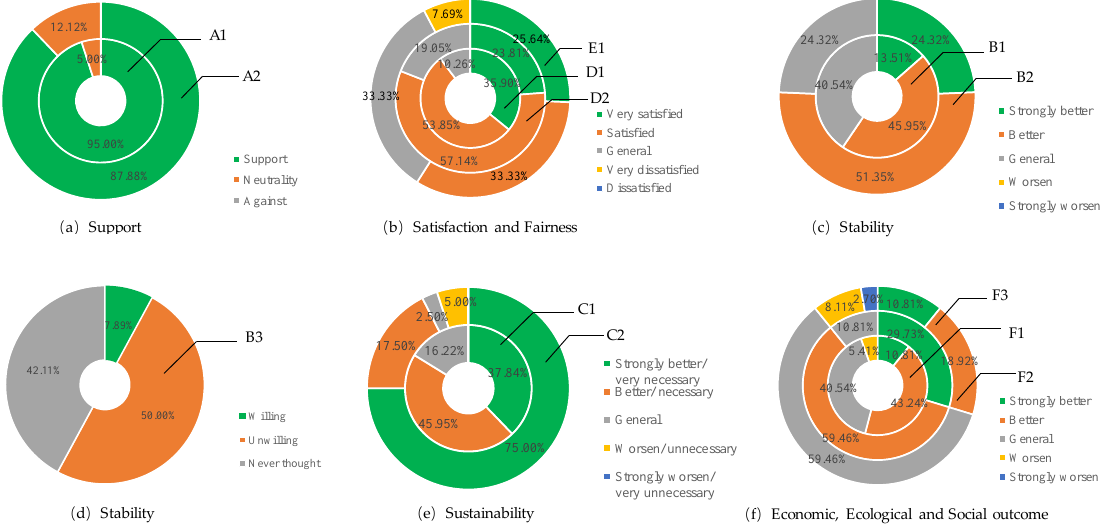
Figure 5. Frequency distribution of rangers’ evaluations on each indicator. ( a ) indicate that the rangers’ perception on NFRPP support. ( b ) indicate that the satisfaction and fairness of NFRPP. ( c ) and ( d ) indicate that the stability of NFRPP. ( e ) indicate that the sustainability of NFRPP. ( f ) indicate that the NFRPP outcome of economic, ecological and social. The indicator code has the same meaning as Table 1.